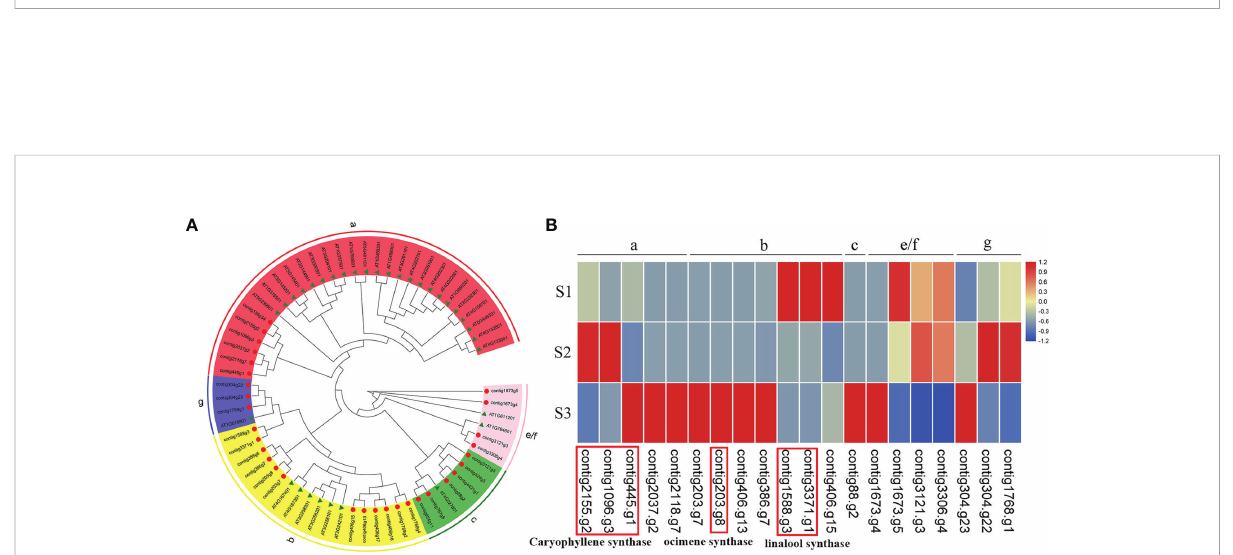
FIGURE 5 The phylogenetic tree and expression of TPS genes in J . sambac cultivar JSDB. (A) The maximum likelihood phylogenetic tree of TPS protein identi fi ed in J . sambac . J . sambac (red circle) and A . thaliana (green triangle) were shown in the tree with corresponding gene ID, respectively. (B) The expression of TPSs at three different fl oral developmental stages (S1, young fl oral bud stage; S2, mature fl oral bud stage; S3, initial opening fl ower stage). Note the genes were expressed in at least one stage.